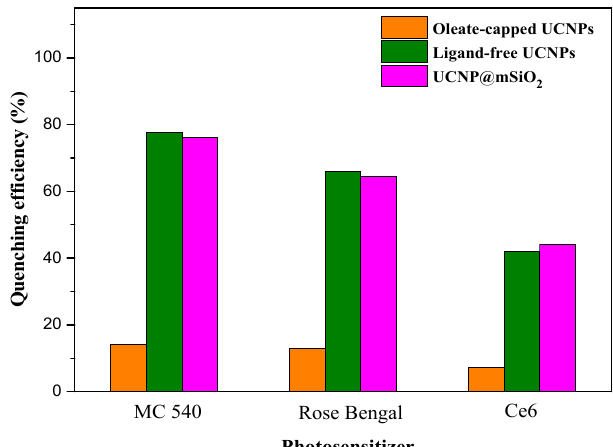
Figure 7. Comparison of quenching efficiency of Ho 3+ -doped UCNP@mSiO 2 / MC 540 pair, Ho 3+ -doped UCNP@mSiO 2 / RB pair and Er 3+ -doped UCNP@mSiO 2 / Ce6 pair with their corresponding oleate-capped and ligand-free type adducts after the occurrence of FRET.